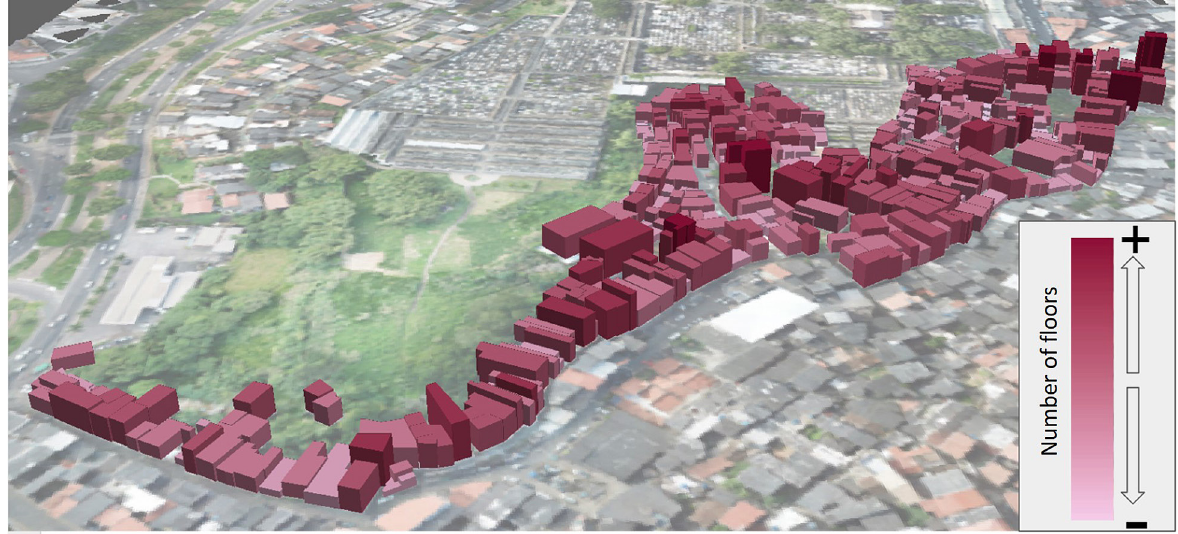
Fig. 7. 3D model with buildings distributed by the number of floors.